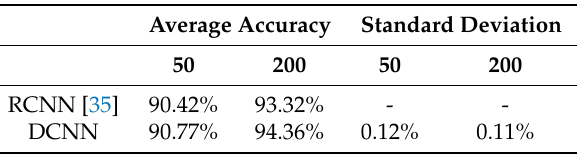
Table 8. Average accuracy scores and their standard deviation on the original train/test split of the WISDM